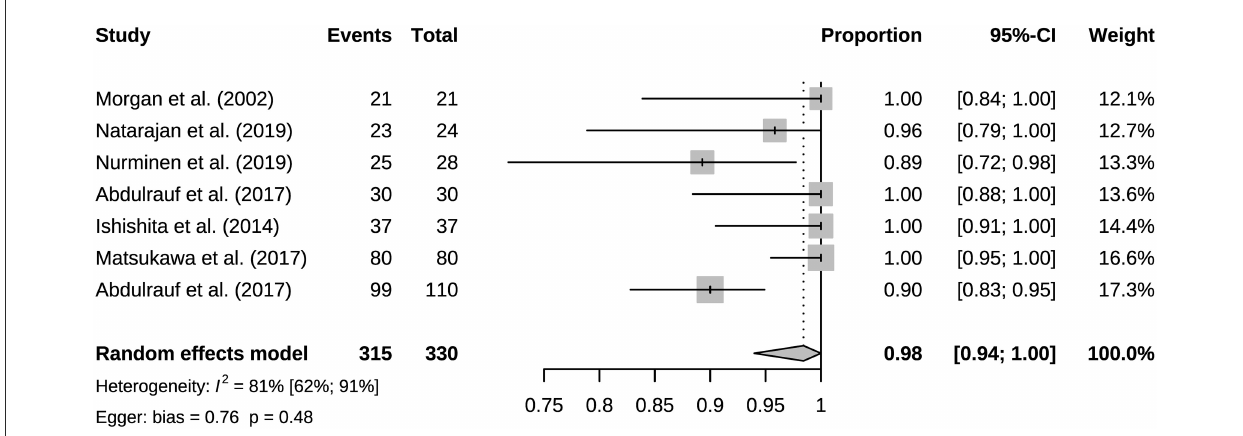
FIGURE3 Short-term follow-up bypass patency of included studies.